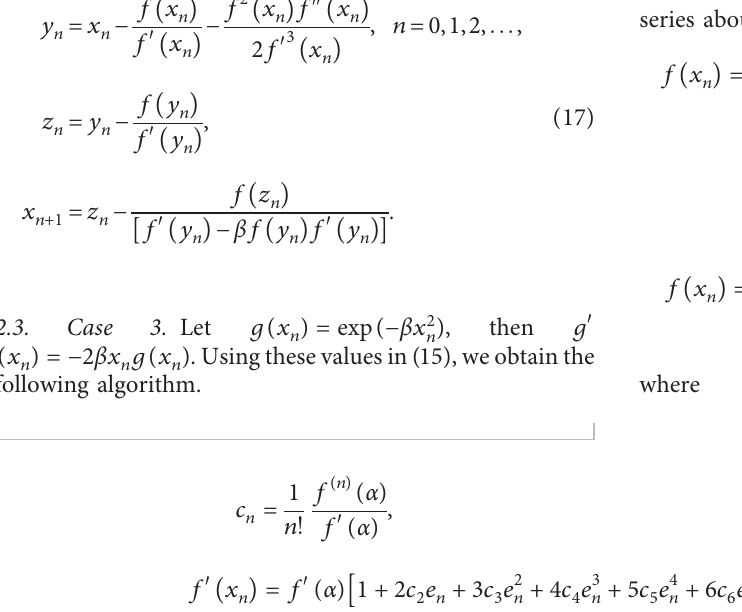
Algorithm 2. For a given x